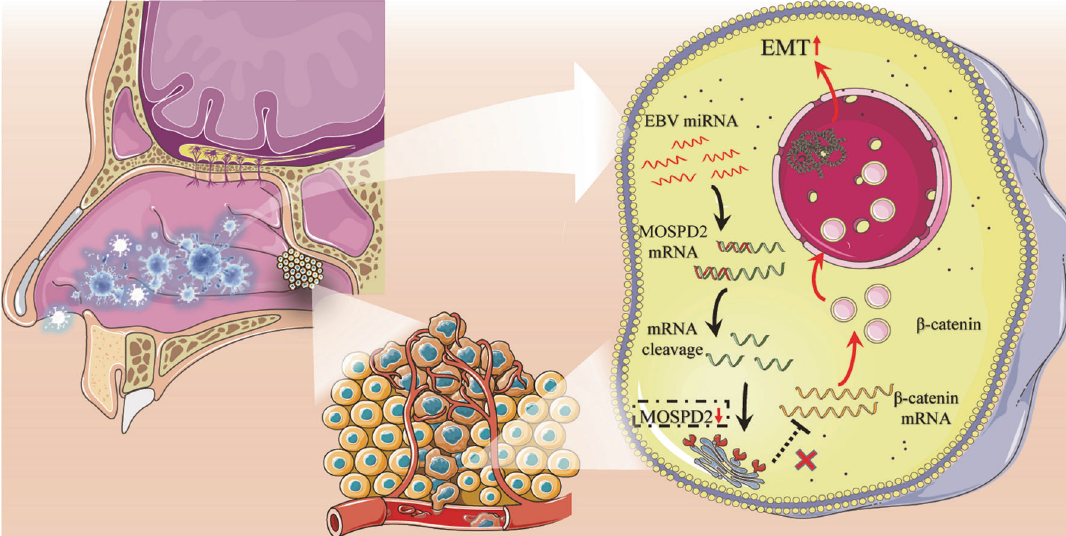
Fig. 8 The schematic summary demonstrating the role of EBV-miR-BART22 in NPC metastasis. EBV-miR-BART-22 plays an oncogenic role by driving the EMT and metastasis of NPC by targeting MOSPD2 and activating the Wnt/ β -catenin